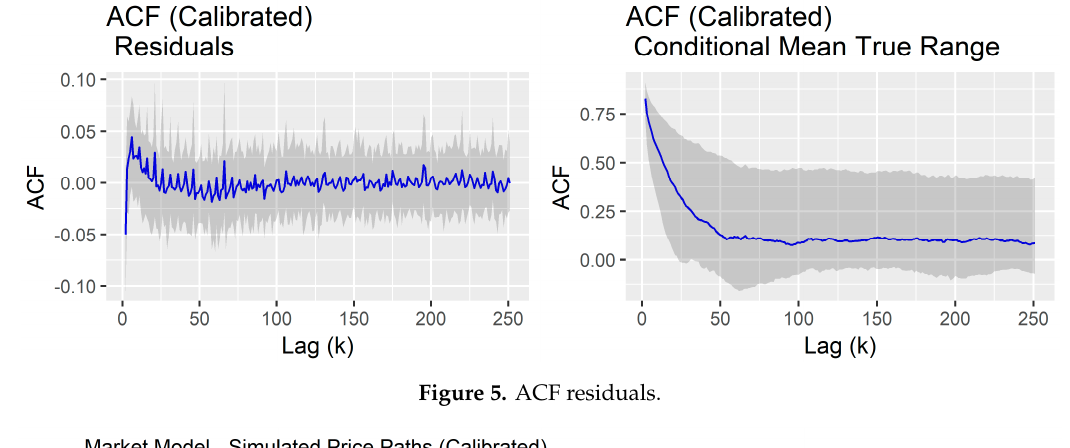
Figure 5. ACF residuals.